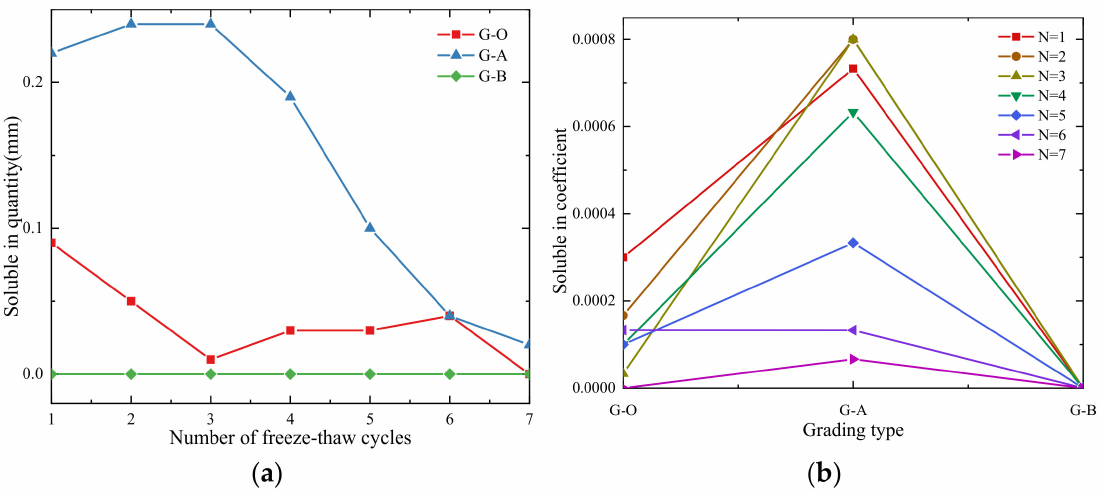
Figure 9. The amount and coefficient of settlement of saline soil at different levels: ( a ) Soluble in quantity ( b ) Soluble in